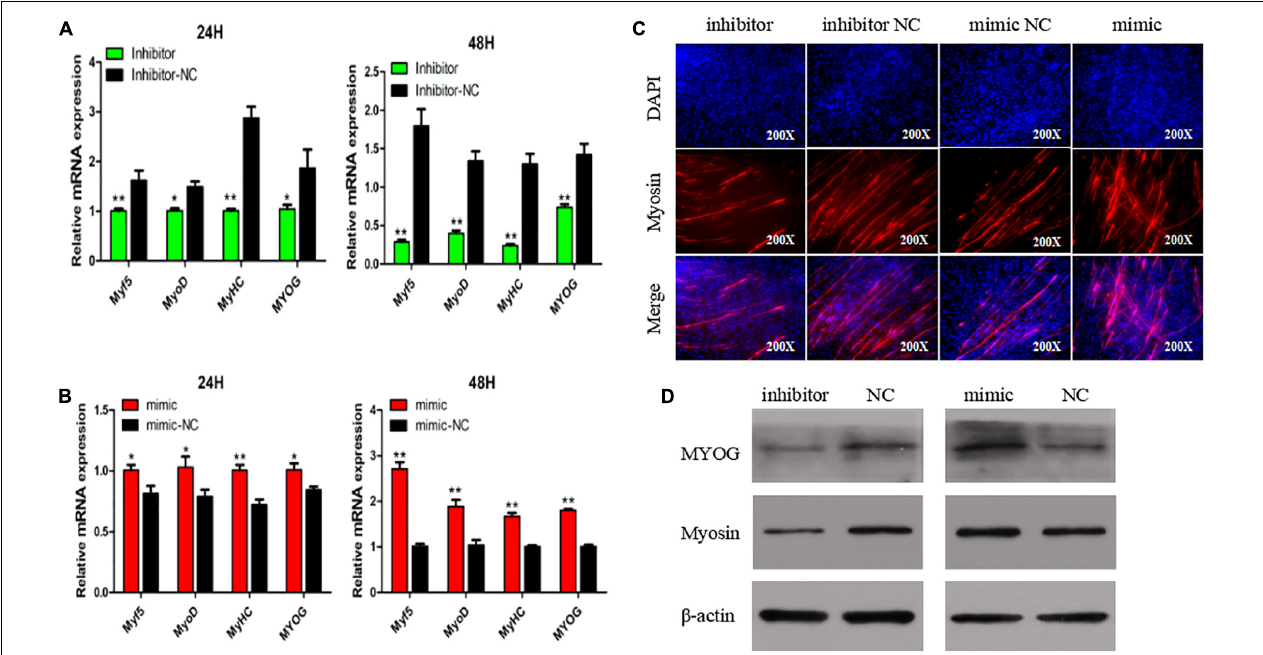
FIGURE 4 | Effect of miR-148a-3p on differentiation of SMSCs. (A,B) Relative expression of mRNA of the genes Myf5, MyoD, MyHC, and MyoG, and abundance of proteins MyoG and Myosin as measured at 48 h of cell differentiation in SMSCs transfected with a miR-148a-3p mimic, inhibitor, or negative control. (C) Representative images of immunofluorescent staining of differentiated SMSCs (200 × ). Myosin: red, a molecular marker of myogenesis; DAPI: blue, cell nuclei; Merge: the fusion of SMSCs into primary myotubes. (D) Western blot detects protein levels of myogenic marker genes after inhibition and overexpression of miR-148a-3p. Data are expressed as mean ± SEM ( N = 3). * P < 0.05; ** P < 0.01 vs.